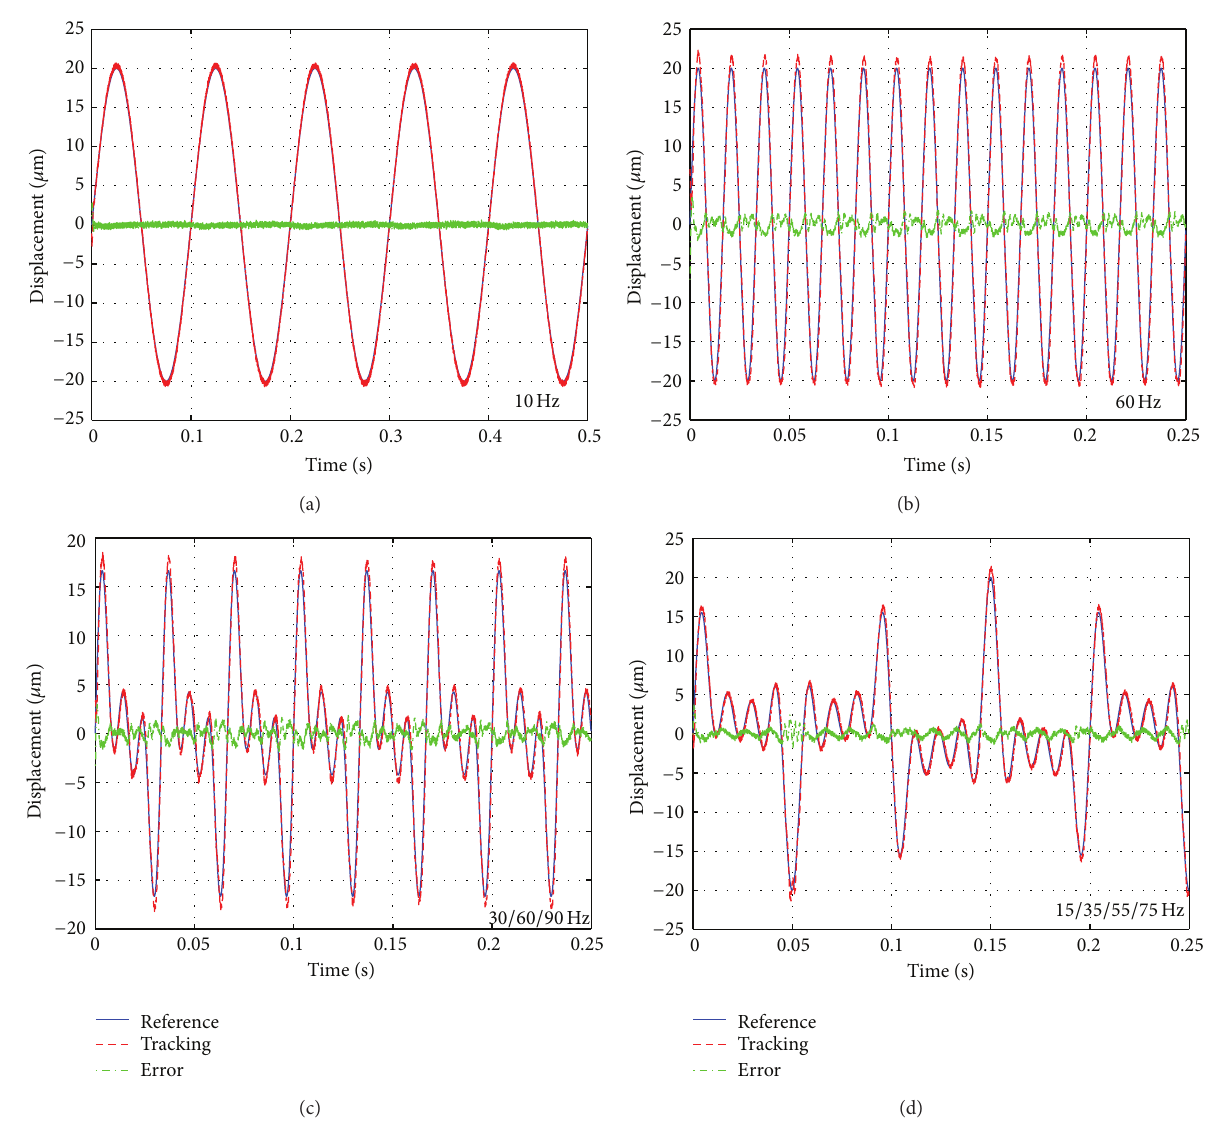
Figure 8: Results of combined tracking